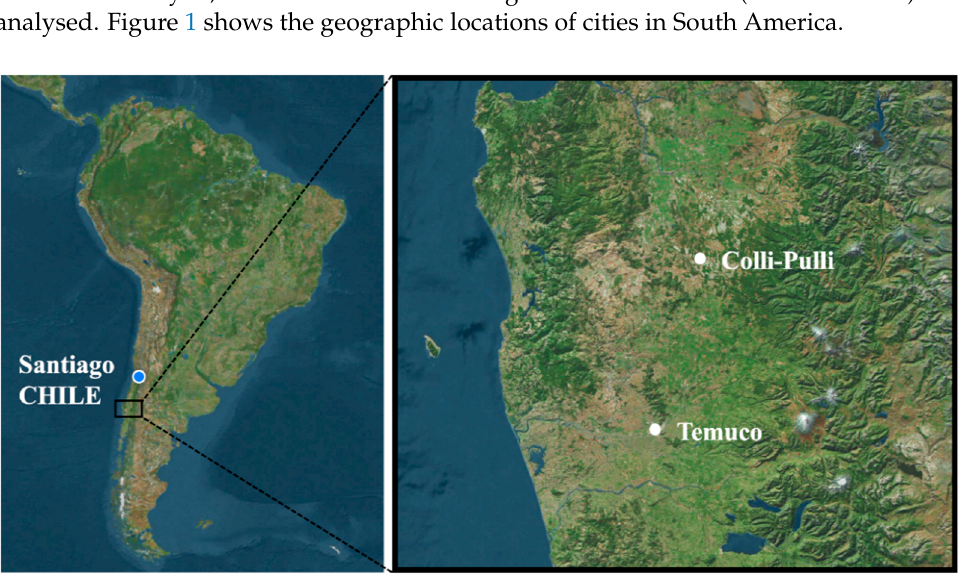
Figure 1. Location of the two municipalities under analysis (Araucanía Region) in southern Chile.